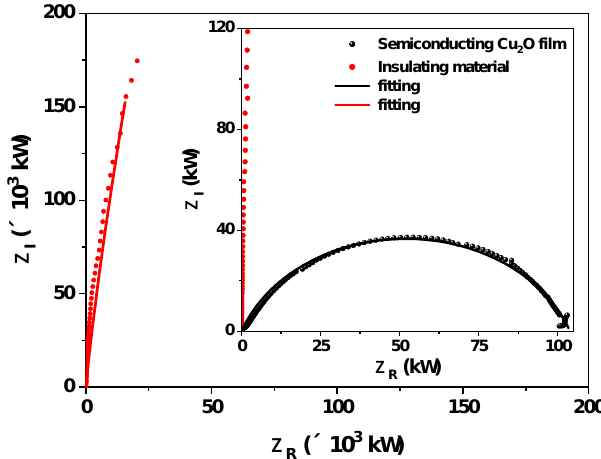
Figure 4. Results of electrical impedance measurements of the insulating Cu 2 O film. For comparison purposes, the inset corresponds to the fit using the circuit model on a semiconductor sample of CuO.